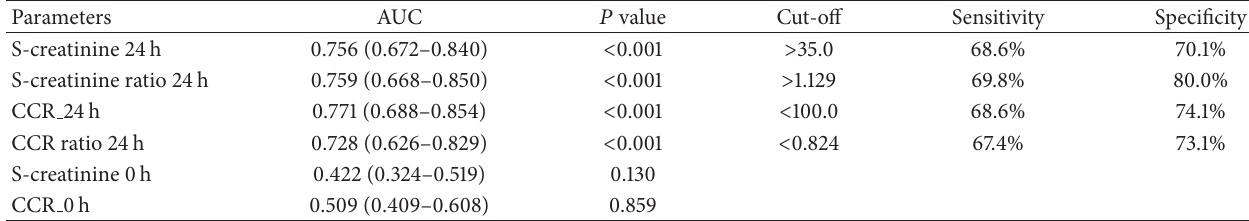
Table 3: The predictive value of S-creatinine, S-creatinine ratio, and CCR for delayed MTX elimination.